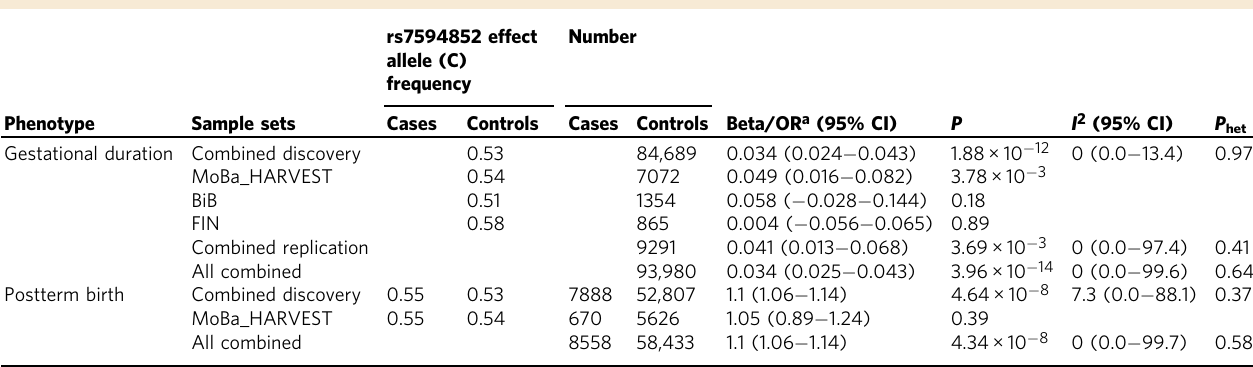
Table 1 Discovery, replication, and combined results for the lead SNP rs7594852 at the 2q13